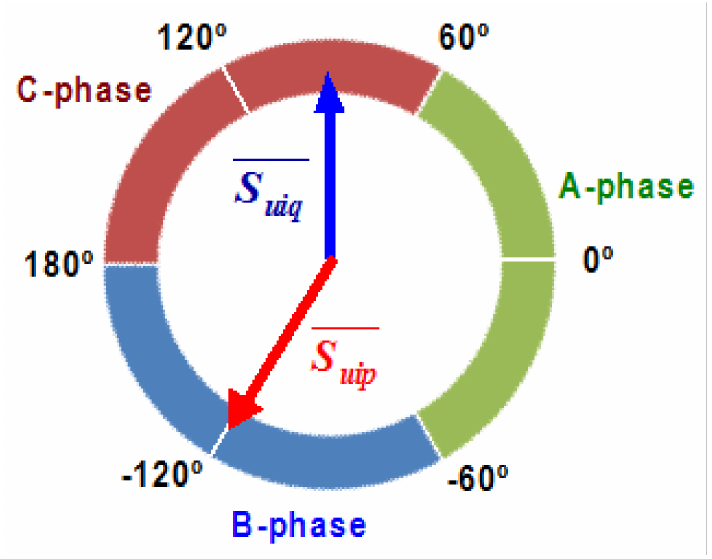
→ S uip (red vector) and